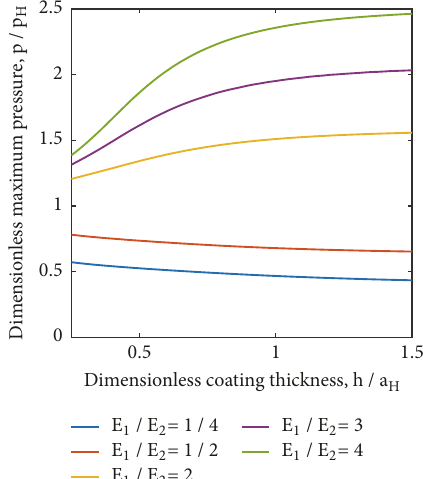
Figure 6: Influence of coating thickness on the maximum pressure 𝑝/𝑝 𝐻